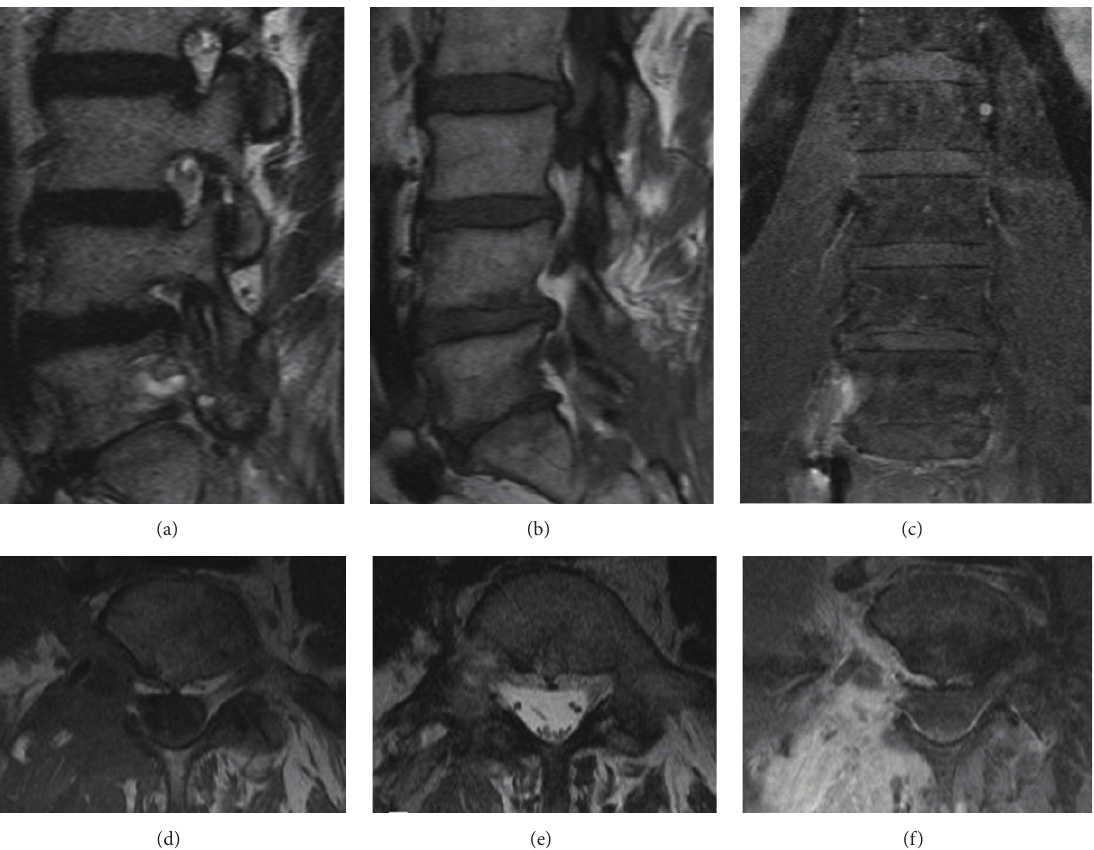
Figure 5: Postoperative spinal MRI. The mass was removed from the vertebral foramen up to the psoas muscle (a, b, and d). Resection of the lesion medially to the psoas muscle was achieved despite its firm adherence to the muscle itself and the risk of vascular injury (c, e, and